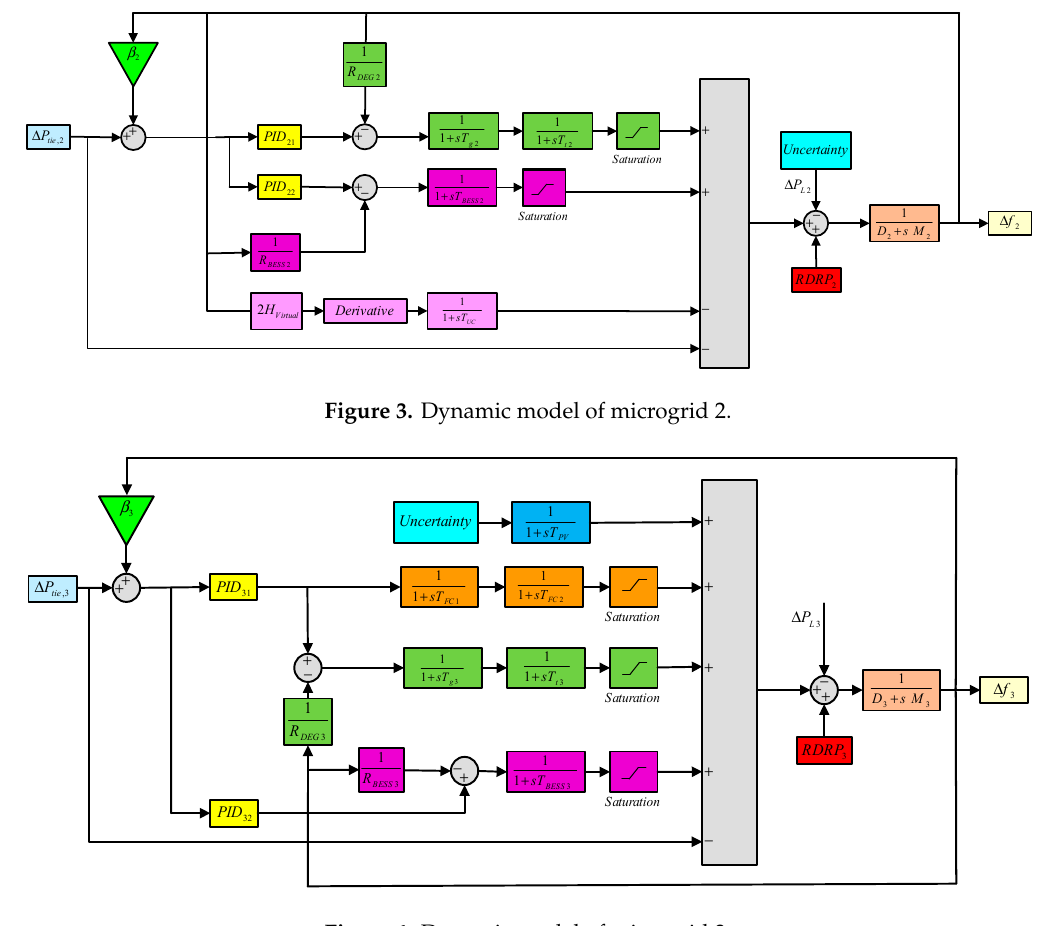
Figure 4. Dynamic model of microgrid 3.